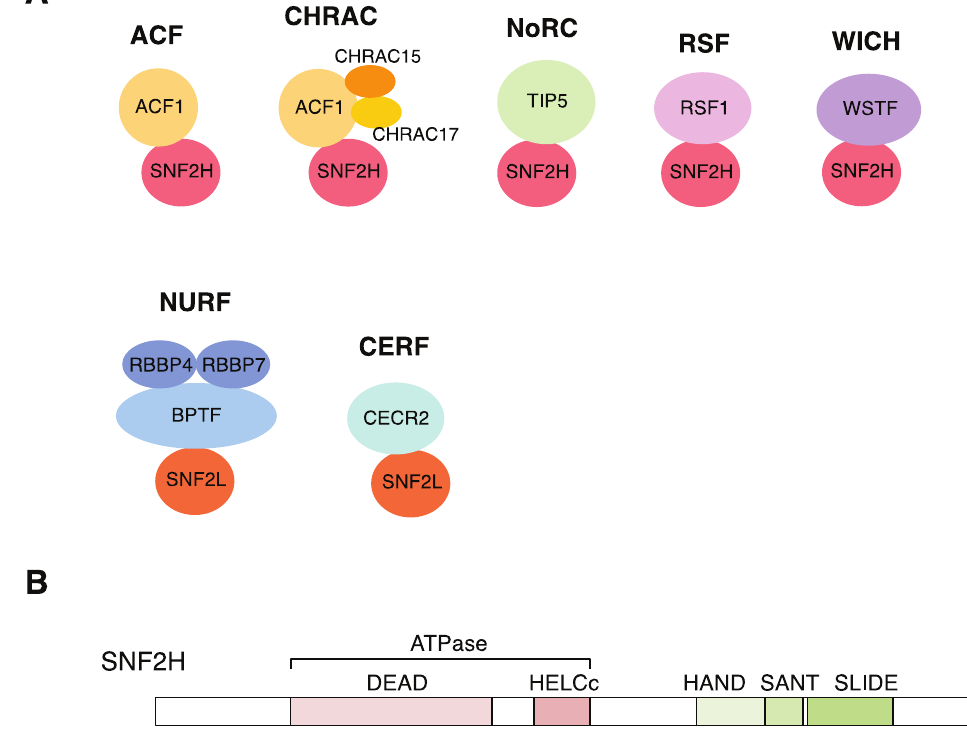
Figure 1. ISWI family of chromatin remodeling complexes in mammal: ( A ) Currently known seven complexes are shown. ( B ) Schematic representation of human SNF2H (sucrose nonfermenting 2 homolog). The ATPase domain is located at N-terminal half of SNF2H. The HSS domain composed of HAND, SANT (Swi3, Ada2, NCoR, TFIIB) and SLIDE (SANT-like ISWI domain) is located at